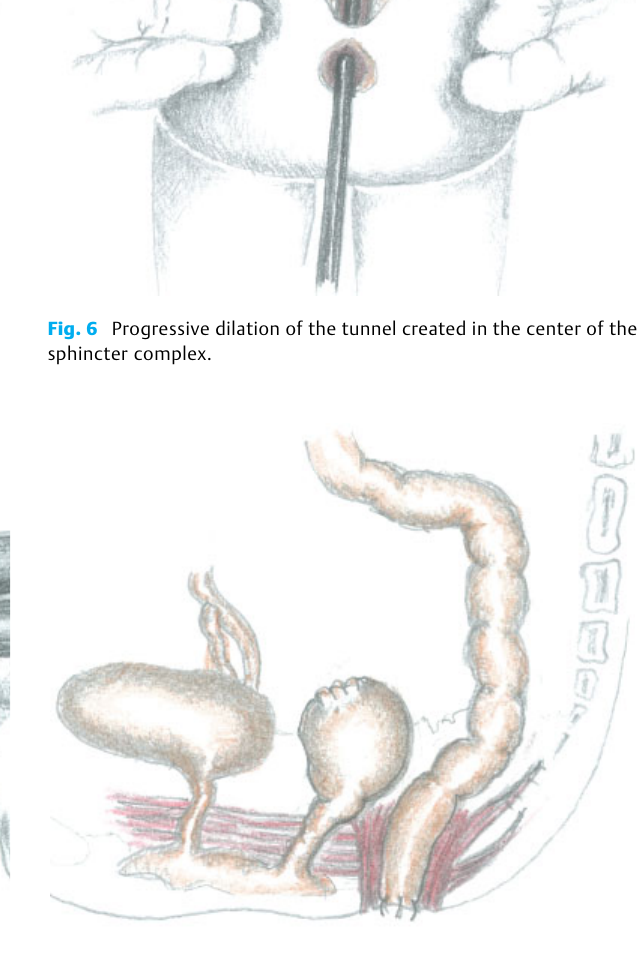
Fig. 7 The sigmoid colon is passed through the dilated tunnel of the sphincter complex and a neoanus is